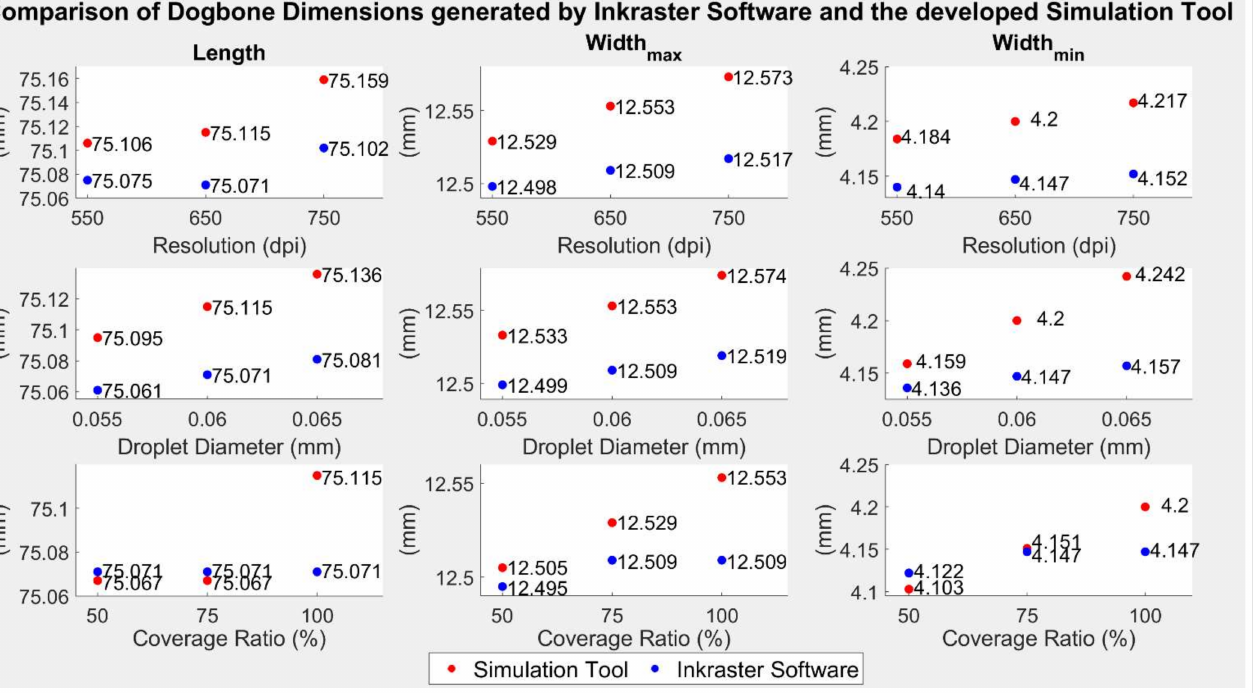
Figure 20. Results of the validation using the “Inkraster”